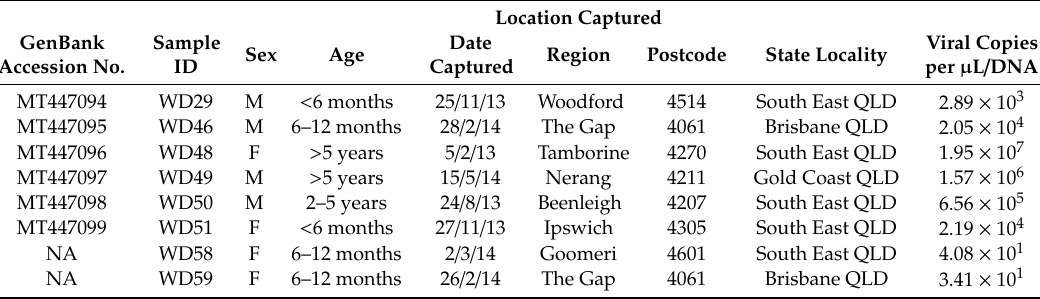
Table 3. Wild-dog samples testing positive for canine parvovirus DNA by quantitative